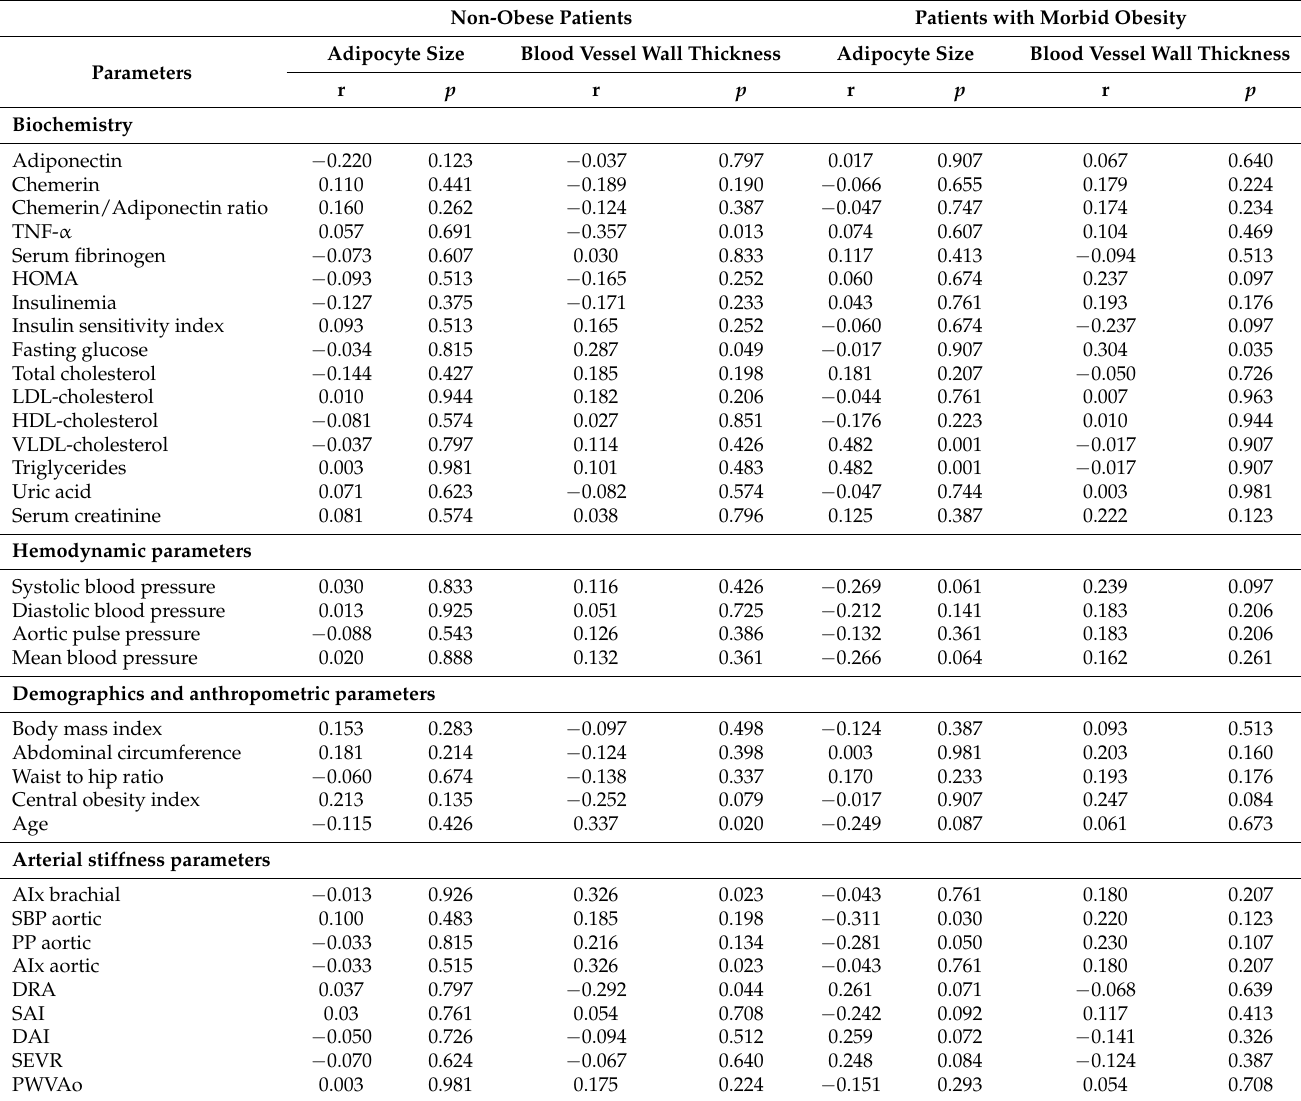
Table 2. Correlations between adipocyte size and blood vessel wall thickness with demographic, clinical and paraclinical